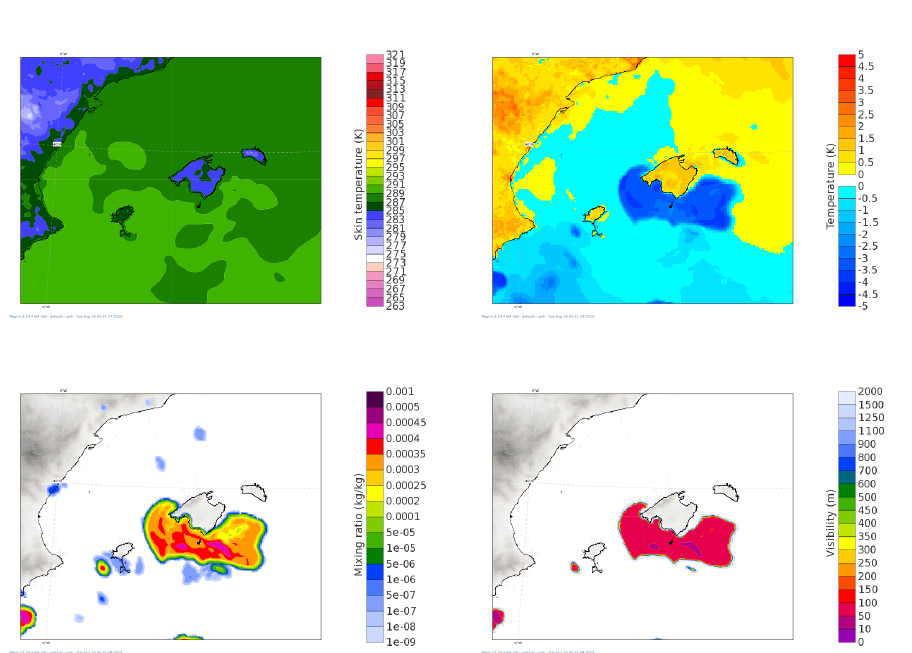
Figure 2. Modelled development of fog around the Balearic Islands, +030 h. ( Top row ): surface temperature (K), ( left ); difference between 2 m temperature and surface temperature (K), ( right ). ( Bottom row ): liquid–water mixing ratio (kg/kg), ( left ); visibility (m), ( right